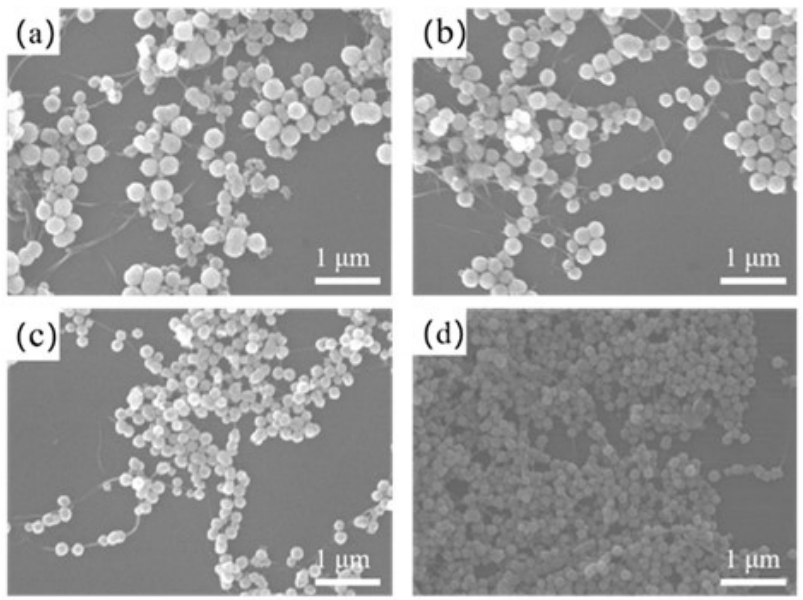
Figure 3. SEM images of CoFe 2 O 4 /SWCNTs composites under Co salt gradient: ( a ) Co-1, ( b ) Co-2, ( c ) Co-3, ( d ) Co-4.